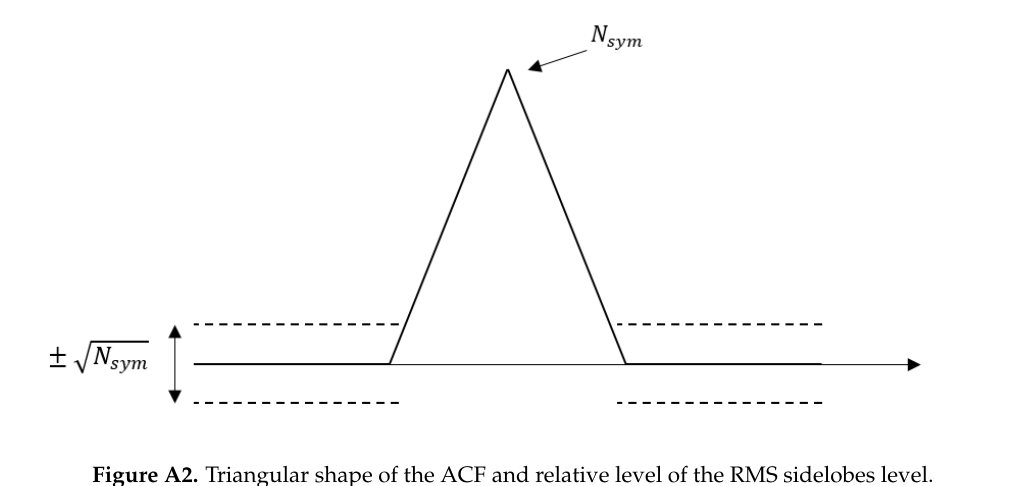
Figure A2. Triangular shape of the ACF and relative level of the RMS sidelobes level.